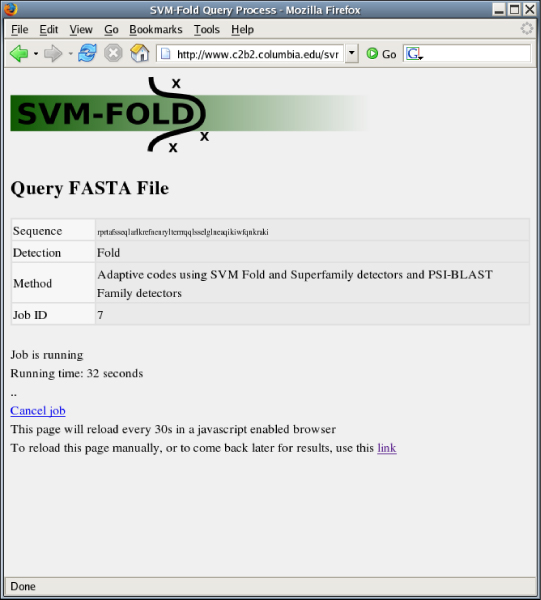
SVM-Fold processing page. A screen capture of the